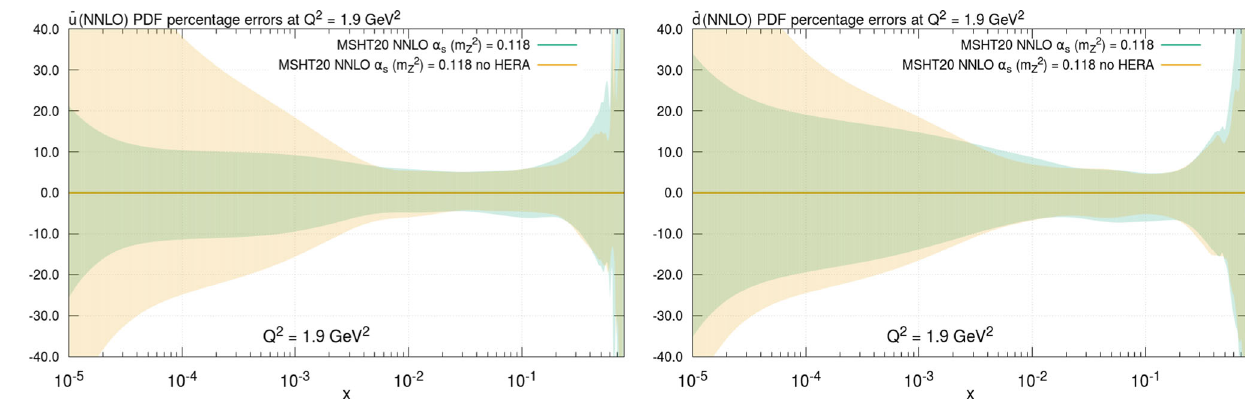
Fig. 77 (Left) ¯ u PDF and (right) ¯ d PDF percentage errors at Q 2 = 1 . 9 GeV 2 at NNLO showing the effect of removing the HERA data from the MSHT20 default global fit